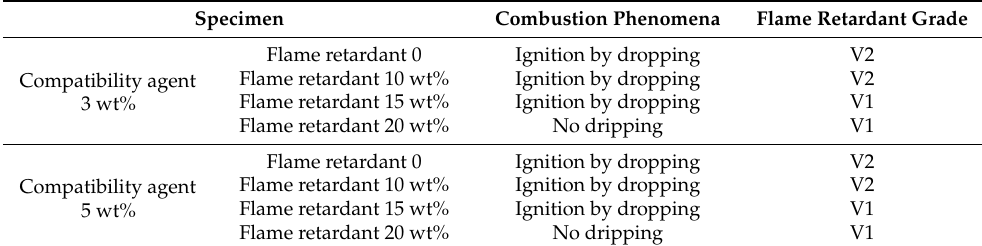
Table 4. Vertical flammability test results.